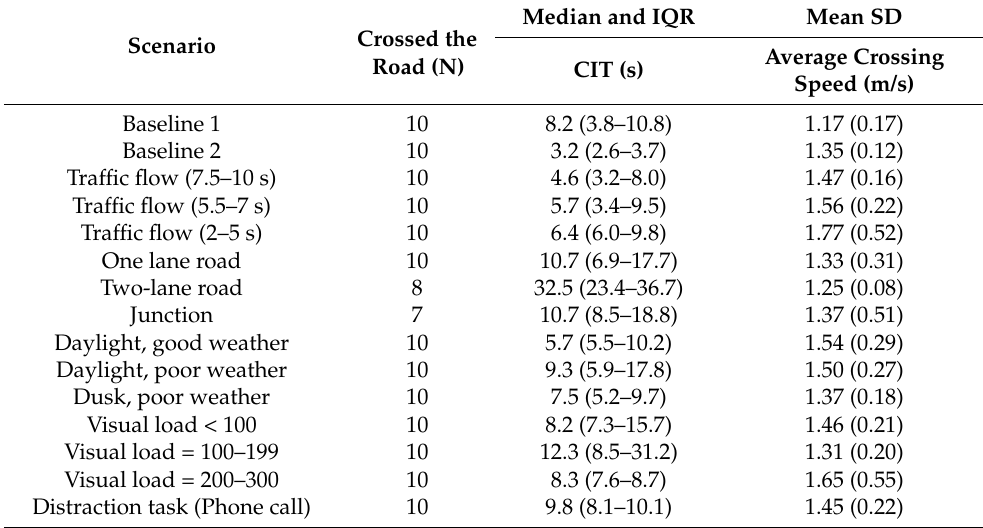
Table 5. Summary of crossing behaviour data for each